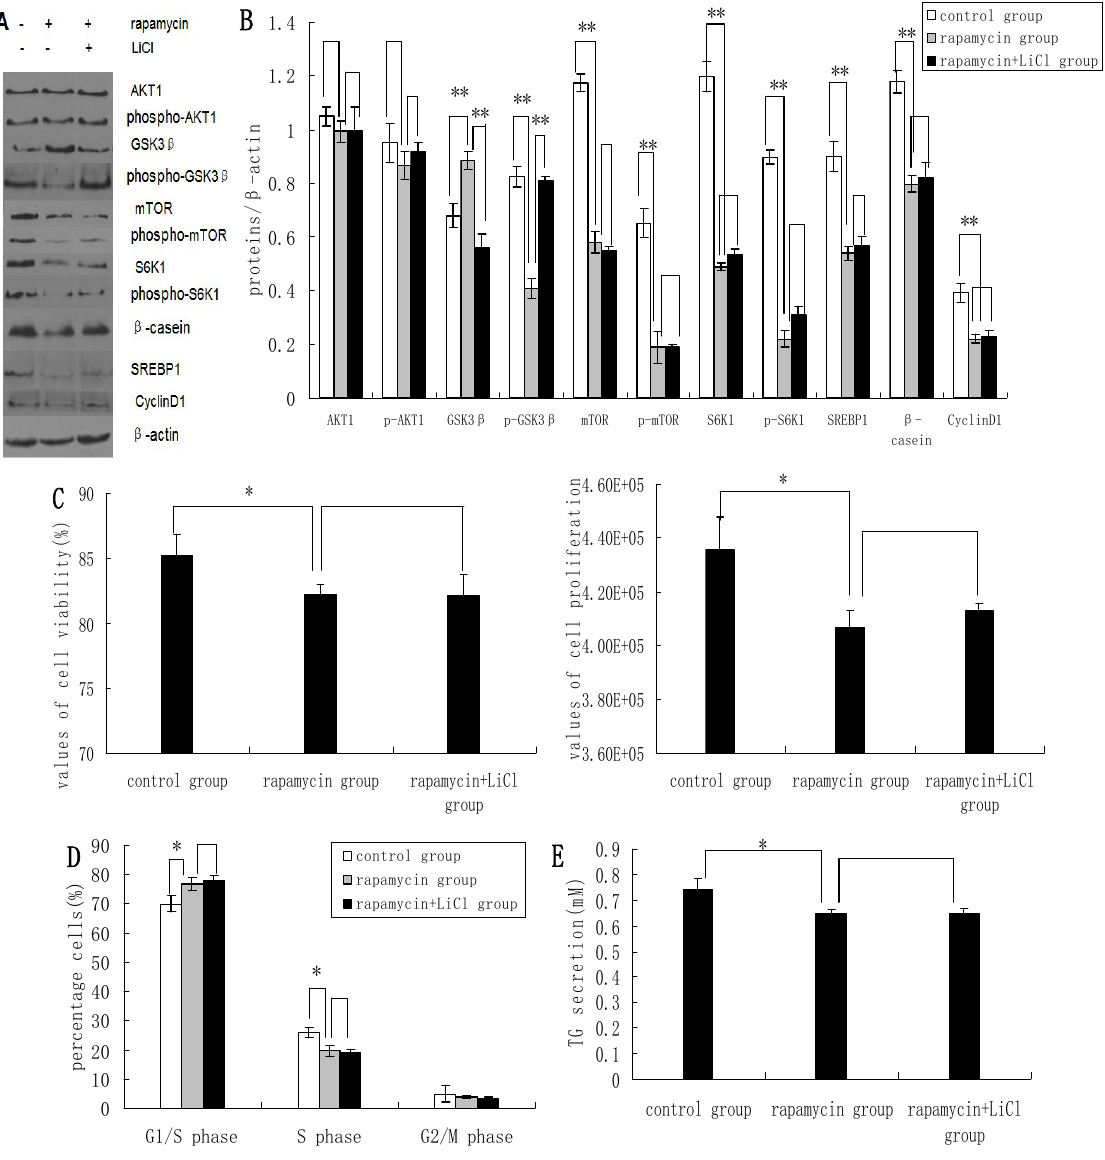
Figure 3. The effects of rapamycin treatment of DCMECs on protein expression, cell proliferation, cell viability, cell cycle, and triglyceride (TG) secretion in the presence and absence of LiCl. Three groups of cells were assessed: a control group (untreated cells), DCMECs treated with rapamycin (1 nM) for 24 h, and DCMECs treated with rapamycin (1 nM) and LiCl (20 mM) for 24 h. Protein expression levels were assessed by western blotting analysis ( A ) and quantified (proteins/ β -actin relative fold) by gray scale scan ( B ). Cell viability and cell proliferation of DCMECs were assessed using a cell counter ( C ) and cell cycle analysis was carried out using flow cytometry ( D ). The TG content in the culture supernatants of DCMECs was measured ( E ). All values represent means ± SE ( n = 3 biological replicates). * p < 0.05 and ** p < 0.01 indicate significant differences between values across two groups as